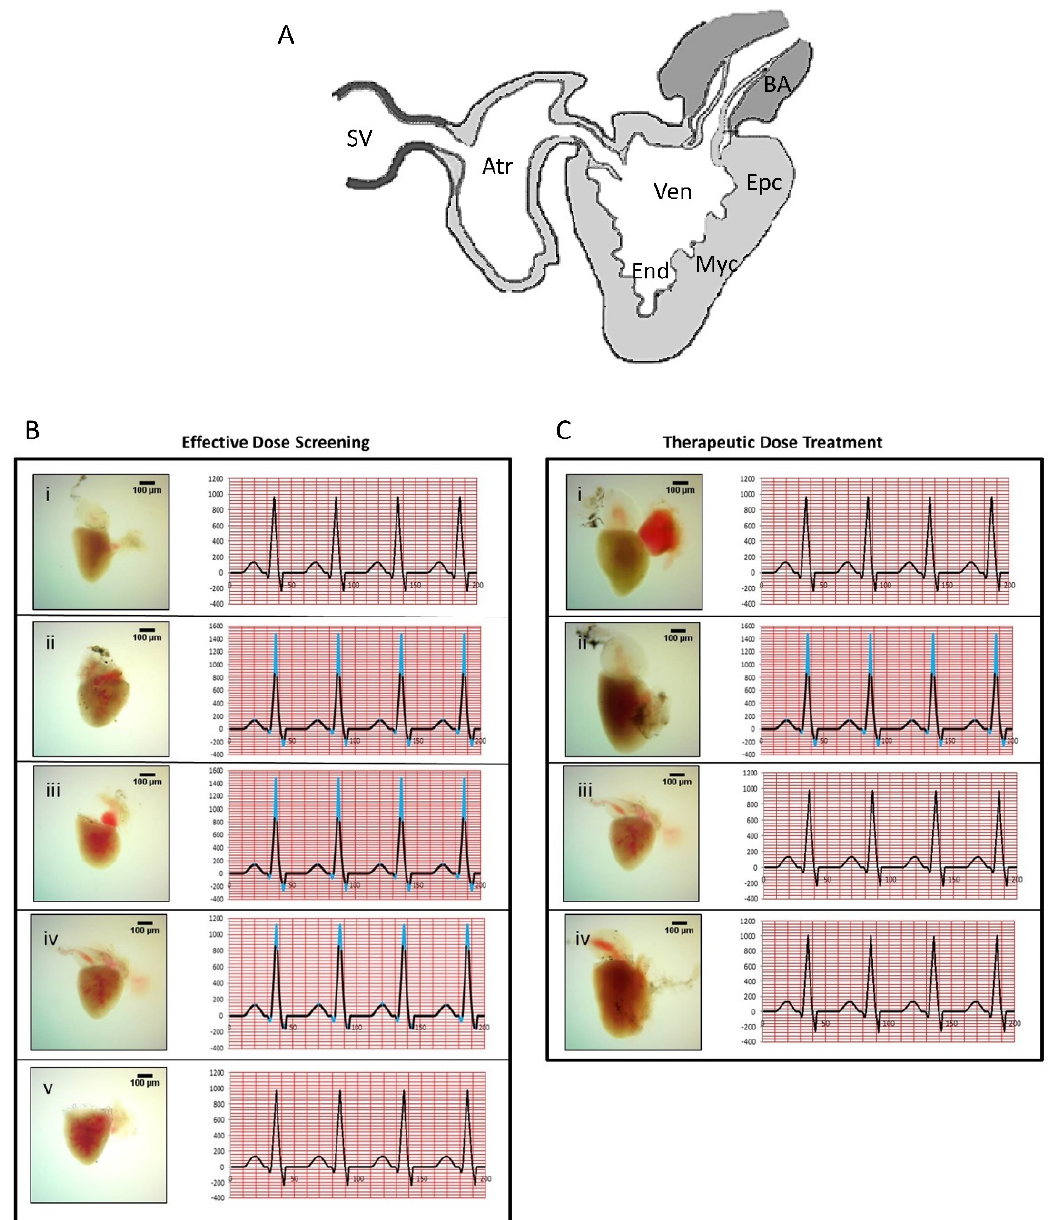
Figure 4. Electrocardiogram (ECG) analysis and whole heart histological analysis of erythromycin (ERY)-stimulated cardiac hypertrophy. ( A ) Schematic diagram of Danio rerio heart: sinus venosus = SV, atrium = Atr, ventricle = Ven, bulbus arteriosus = BA, epicardium = Epc, myocardium = Myc, endocardium = End (graphics adapted from Yacoub et al. [32]). ( B ) In the effective dose screening analysis, ECG and heart anatomy of the D. rerio were studied for ( i ) normal control; ( ii ) disease control (25 µg/Lt erythromycin (ERY)); ( iii ) low dose (0.6 µg/kg of YDR); ( iv ) medium dose (4 µg/kg of YDR); and ( v ) high dose (18 µg/kg of YDR). The results indicated induction of CH by ERY. No changes were detected in the CH parameters following the 7 days of effective dose treatment with YDR at the low and medium doses. Mild changes were observed at the highest tested dose of YDR. ( C ) In the therapeutic dose treatment study, D. rerio were grouped as ( i ) normal control; ( ii ) disease control (25 µg/Lt ERY); ( iii ) standard drug (4 µg/kg of verapamil); ( iv ) therapeutic dose of YDR (18 µg/kg of YDRY). The results indicated that, following 14 days of treatment, both the verapamil and YDR successfully ameliorated the CH induced by ERY in D. rerio .